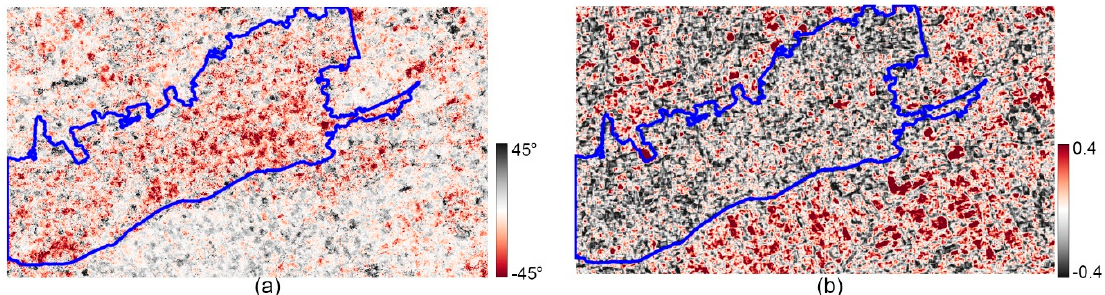
Figure 11. Comparison of ( a ) fully polarimetric damage indicator ( ∆ α D ) and ( b ) single-polarization damage indicator ( 𝑧 -factor).